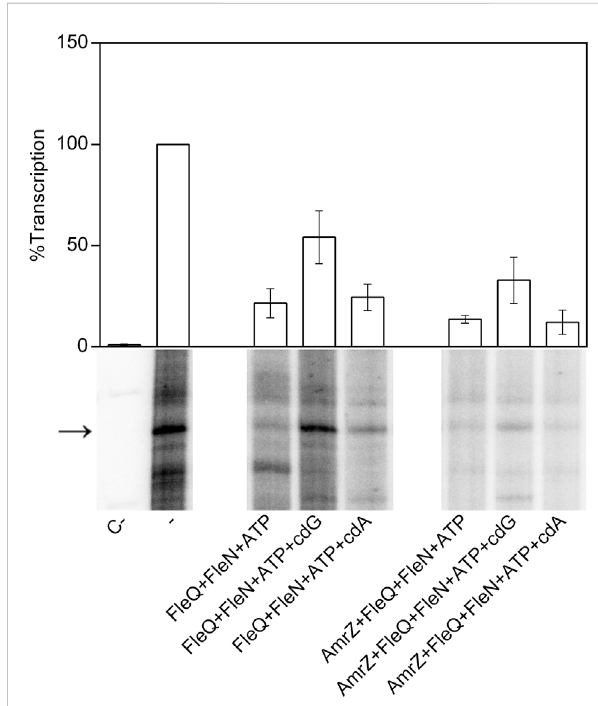
FIGURE 7 In vitro transcription. Multiple round transcription assays were carried out as described in Materials and Methods. The assays were performed in the absence (-) or in the presence (+) of FleQ, FleN or AmrZ. When indicated, ATP, c-di-GMP or c-di-AMP were also added to the reaction. C- indicates a reaction without template DNA. The 232 nucleotide mRNA synthesized from P wssA is point out by an arrowhead. The graph shows the average amount of the mRNA producedaspercentage oftheconditionwithoutanyprotein(-).Error bars correspond to the standard deviation of six differenttranscription